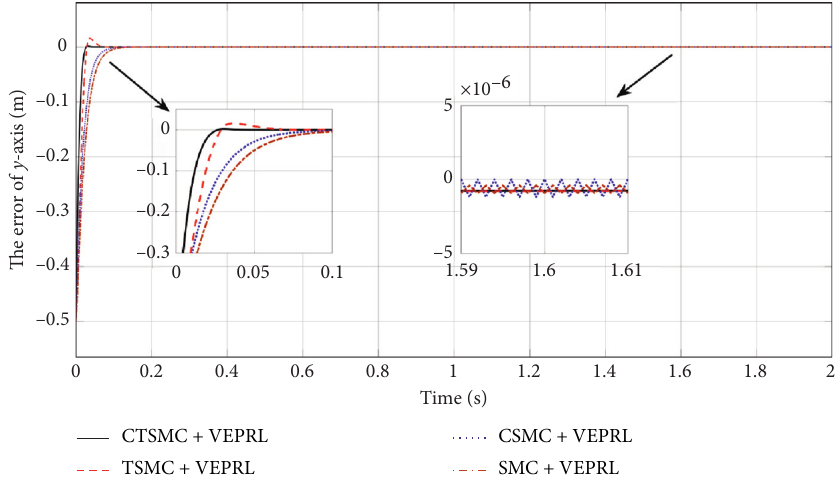
Figure 10: Comparison of y -axis tracking error of the ball and plate system under